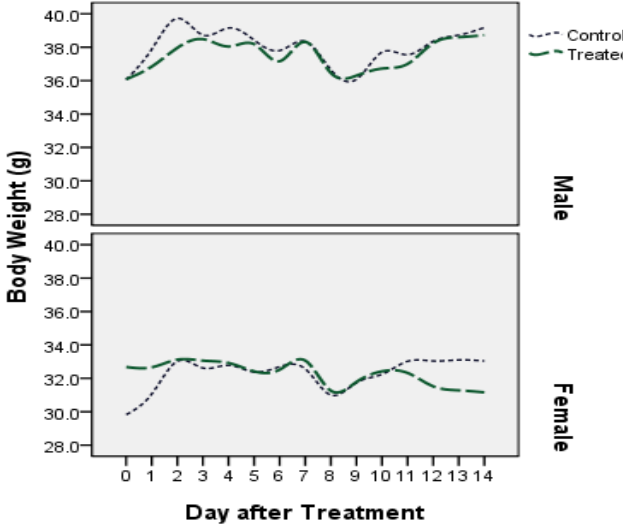
Figure 1. Comparing the changes in body mass across sexes in control and treatment groups during fortnight observation based on acute toxicity test of leaf extract of L. camara on Swiss Albino Mice.